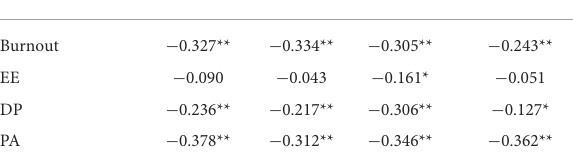
TABLE 2 Correlation analysis between burnout and work engagement. Classification